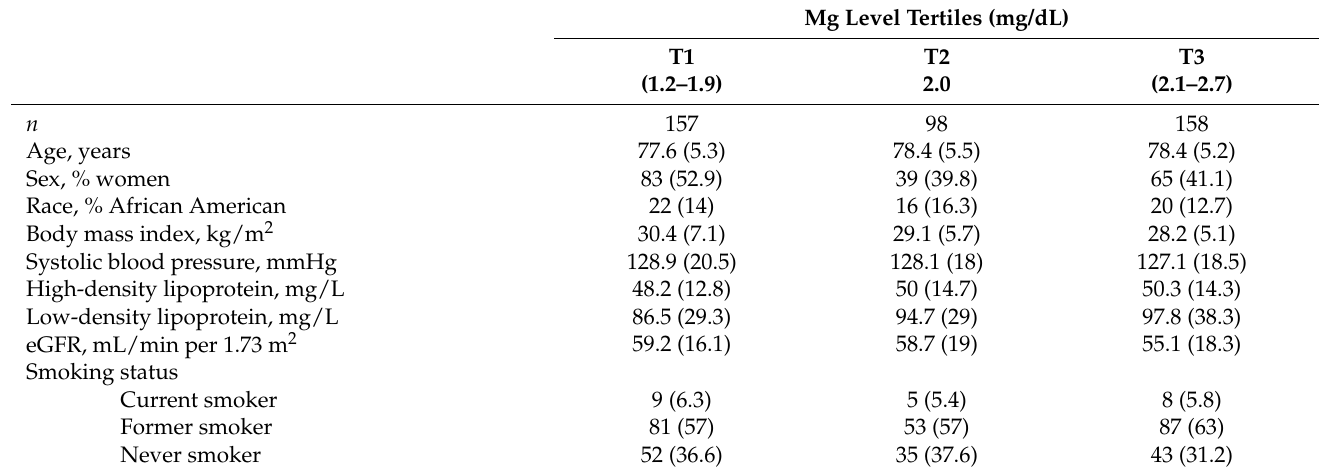
Table 1. Visit 5 characteristics of participants in ARIC grouped by Mg concentration tertiles ( n =